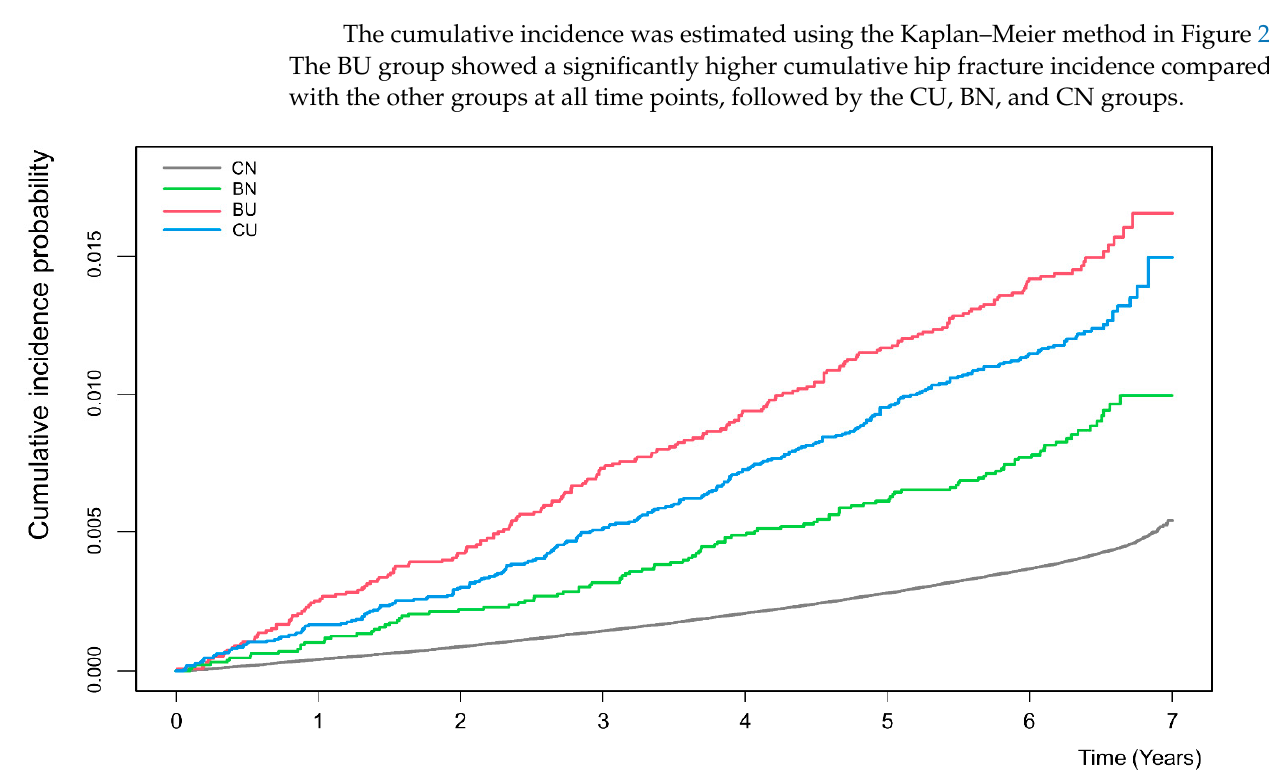
Table 2. Hazard ratios for hip fracture according to changes in underweight status in adults ≥ 40 years old.